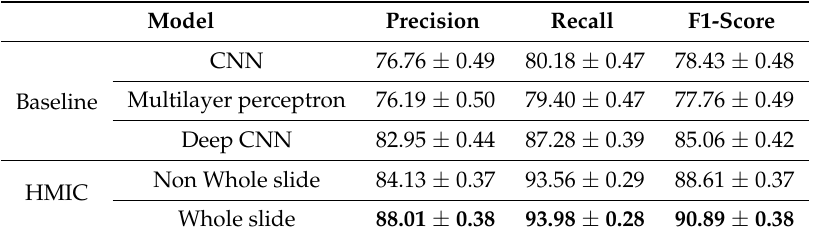
Table 4. Results of HMIC with comparison with our